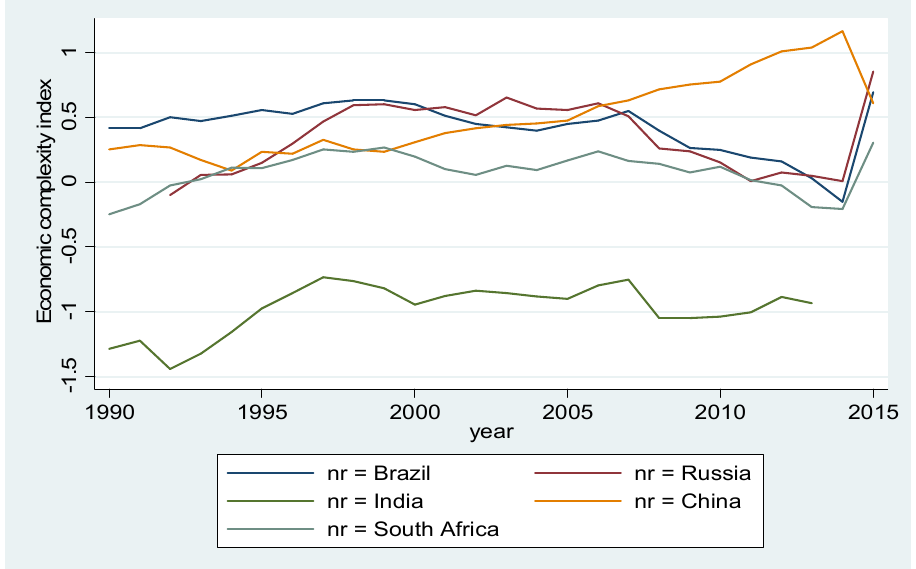
Figure 3. Panel data distribution of economic complexity index. Source: Authors’ elaboration based in Atlas Database (2021).